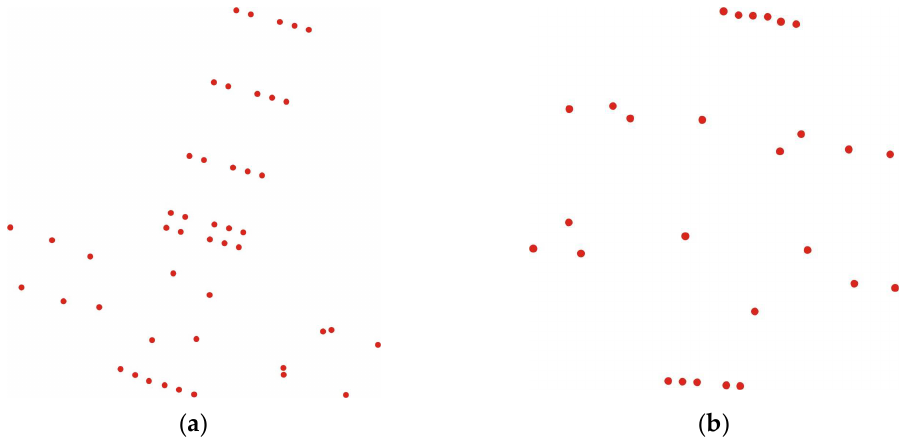
Figure 7. ( a ) Dotted 3D model of the borehole; ( b ) Dotted 3D model of the resulting expansion of the borehole [4].